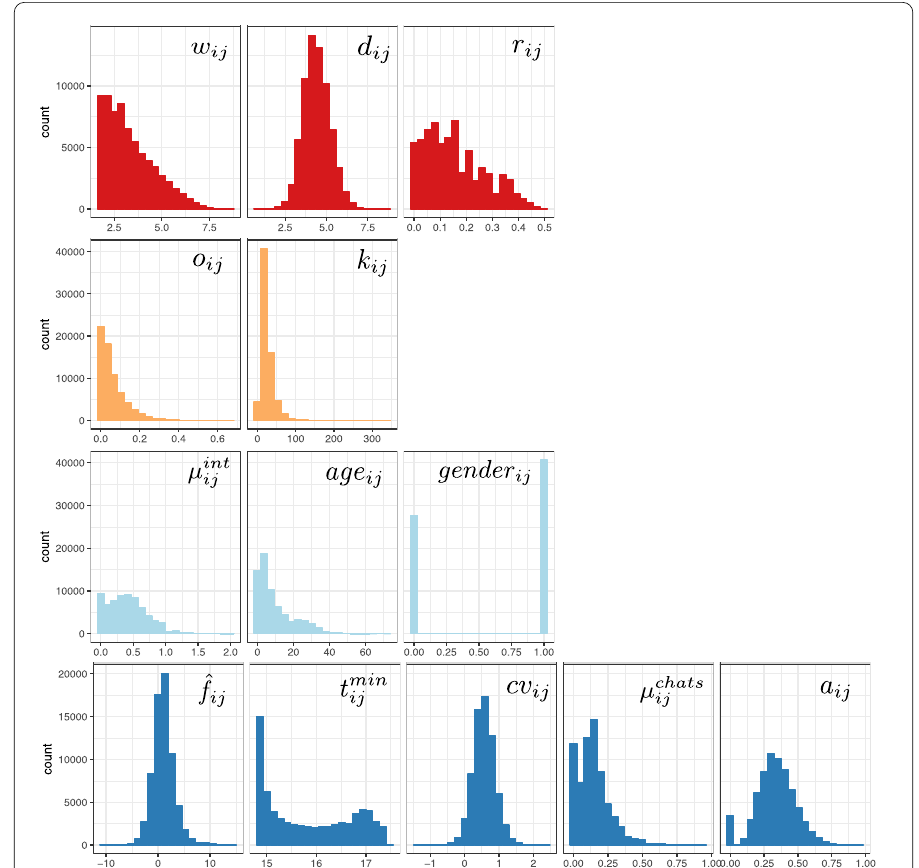
Figure 6 Correlation between features. Correlation matrix for the different tie features considered in the model. Each entry shows the Pearson correlation coefficient between two variables. Size is proportional to the absolute value of the correlation coefficient, while color shows also its sign. We only show correlation coefficients which are significantly different from zero (with a 95% confidence